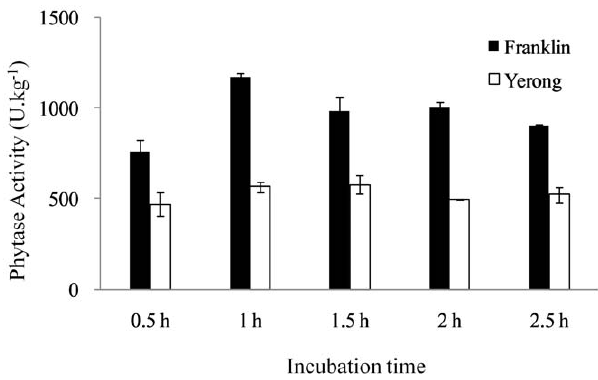
Figure 1. Effect of incubation time on phytase activity in Yerong and Franklin